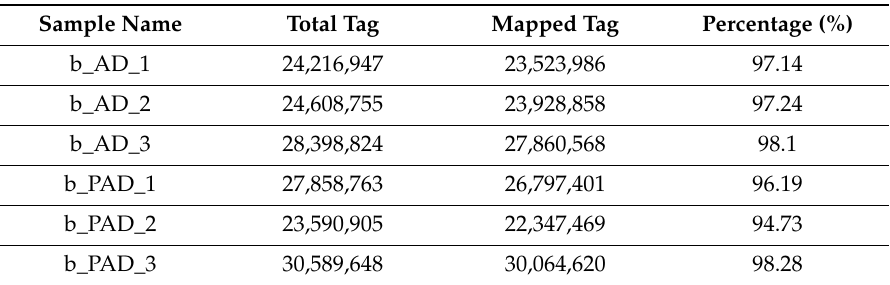
Table 3. The statistical data of RNA